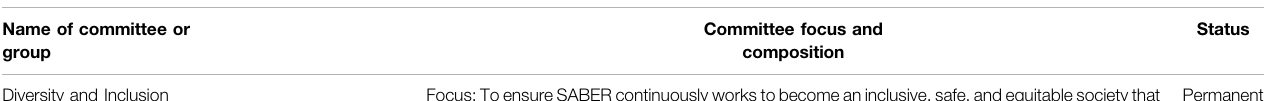
TABLE 1 | SABER committees involved in antiracist